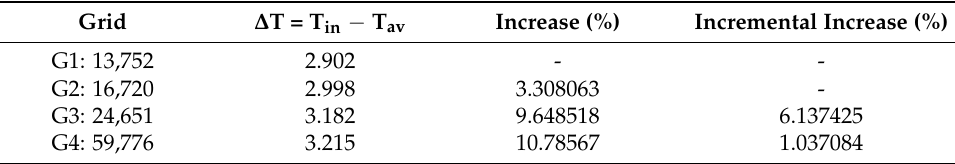
Table 3. Grid independency test, for Case 3, u in = 3 m/s, and T in = 45 ◦ C.